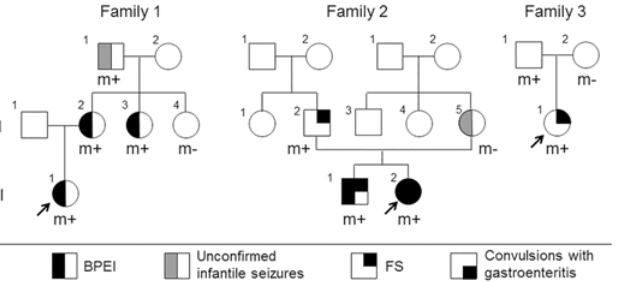
Fig 1. Family trees of three families harboring CLCN6 variants. CLCN6 variant-positive members are presented as (m+), and CLCN6 variant-negative members are presented as (m-). Arrows indicate the proband in the